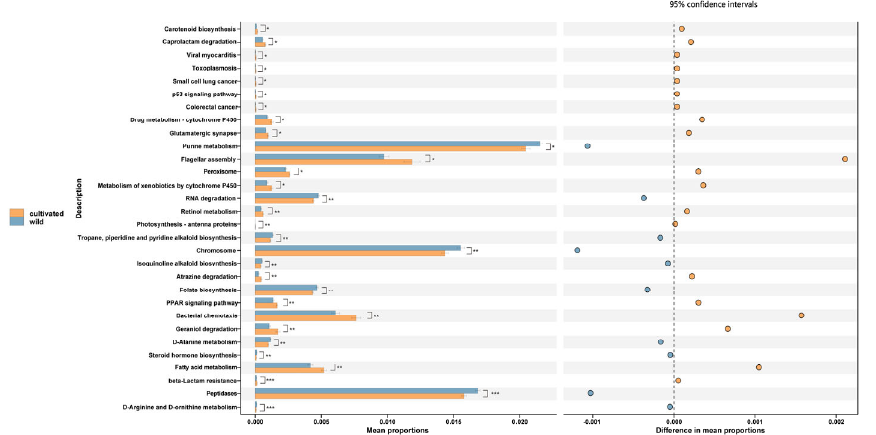
Figure 5. STAMP difference analysis of functional predictions of endophytic fungi in wild and cul- tivated L. delavayi leaves based on the KEGG database (level 3). The STAMP analysis results in the figure only apply to the first 30 functions with p < 0.05 in the t − test difference test results of two comparisons. In the figure, * represents 0.01 < p < 0.05, ** represents 0.001 < p < 0.01, and *** represents p < 0.001. The results showed statistically significant functions (95% confidence